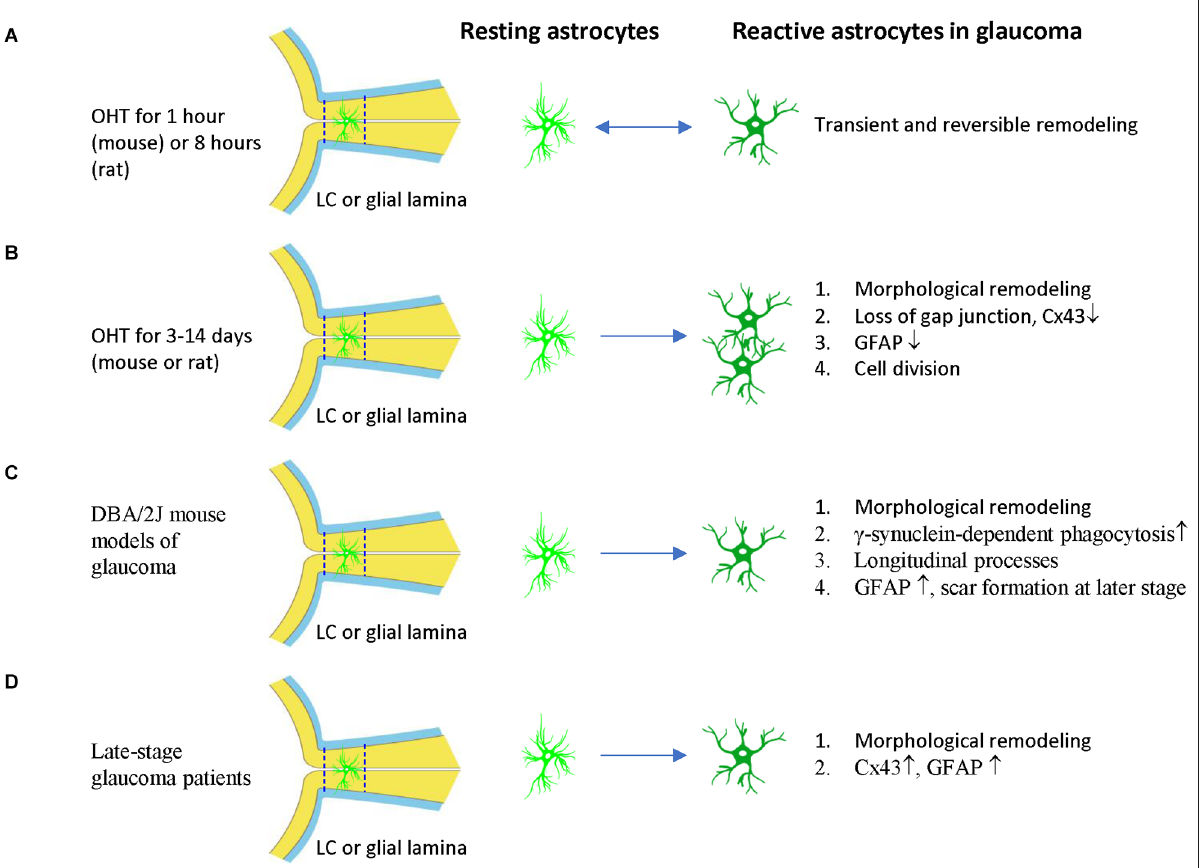
FIGURE4 ONH astrocyte activation in glaucoma is heterogeneous and stage dependent. (A) Transient OHT induces reversible morphological remodeling of ONH astrocytes. (B) In the early stage of OHT, morphological remodeling persists, Cx43 and GFAP expression of ONH astrocytes are reduced. Cell division and cell number increased. (C) In DBA/2J mouse models of glaucoma, γ -synuclein-dependent phagocytosis increased, astrocyte spout longitudinal and GFAP − processes. At late-stage, astrocytes can form scars. (D) In late stage of glaucoma patients, ONH astrocytes have morphological remodeling and increased expression of CX43 and GFAP. The two dash lines label the position of LC (human) or glia lamina (rat or mouse). LC, lamina cribrosa; OHT, ocular